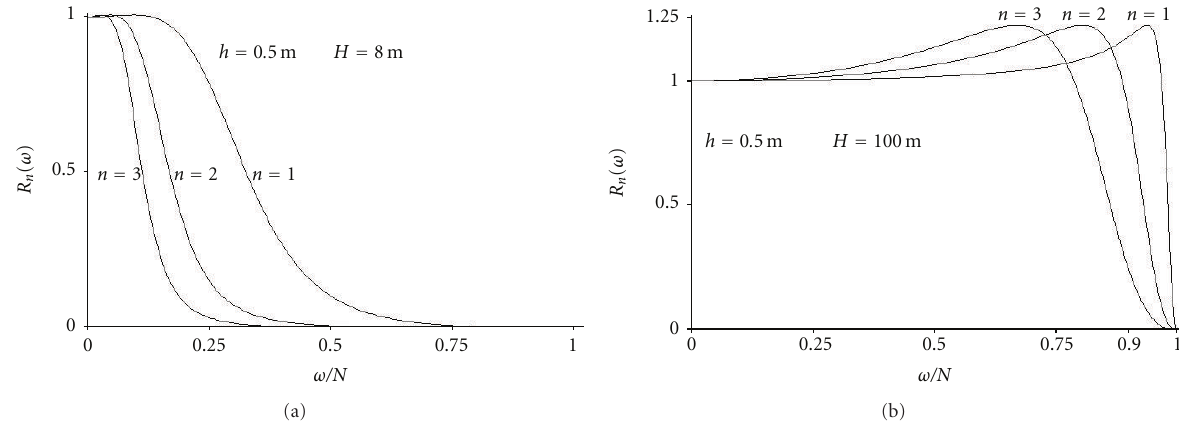
Figure 1: Transfer function determining the correction factor for the hydrostatic relation between the amplitudes of the near-bottom pressure and the ice deflection with the thickness of the ice cover h = 0 . 5m and the sea depth (a) H = 8m ( K = 2 × 10 5 N / m 2 ) and (b) H = 100m ( K = 10 6 N / m 2 ).